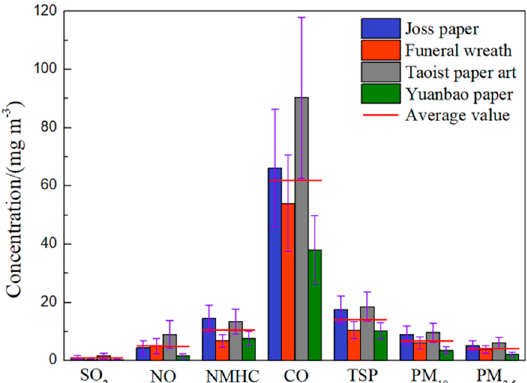
Figure 5. Average emission concentrations of pollutants from the incineration of the four sacrificial